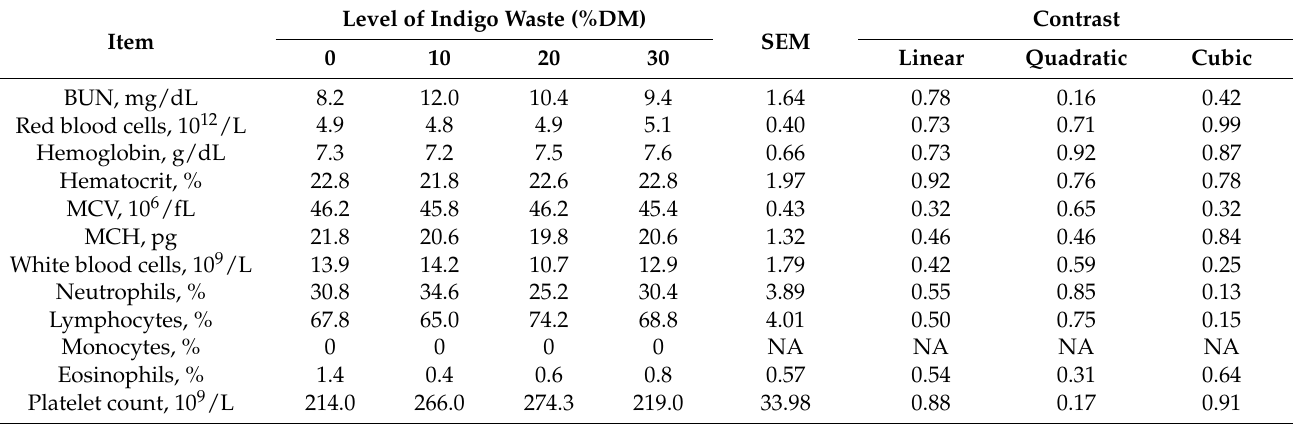
Table 8. Effect of indigo waste on BUN and hematology in growing beef cattle.